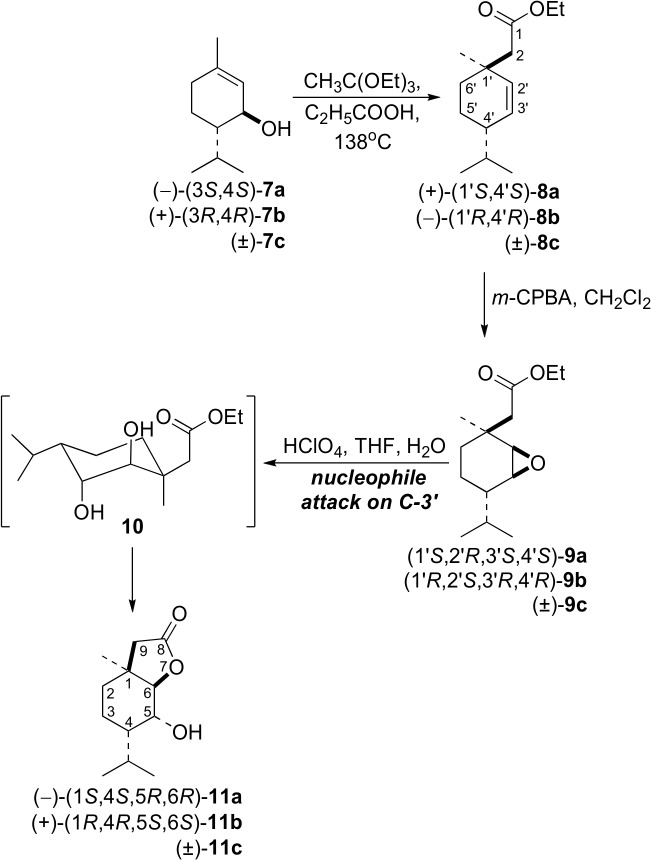
Synthesis of hydroxy lactones 11a-c.